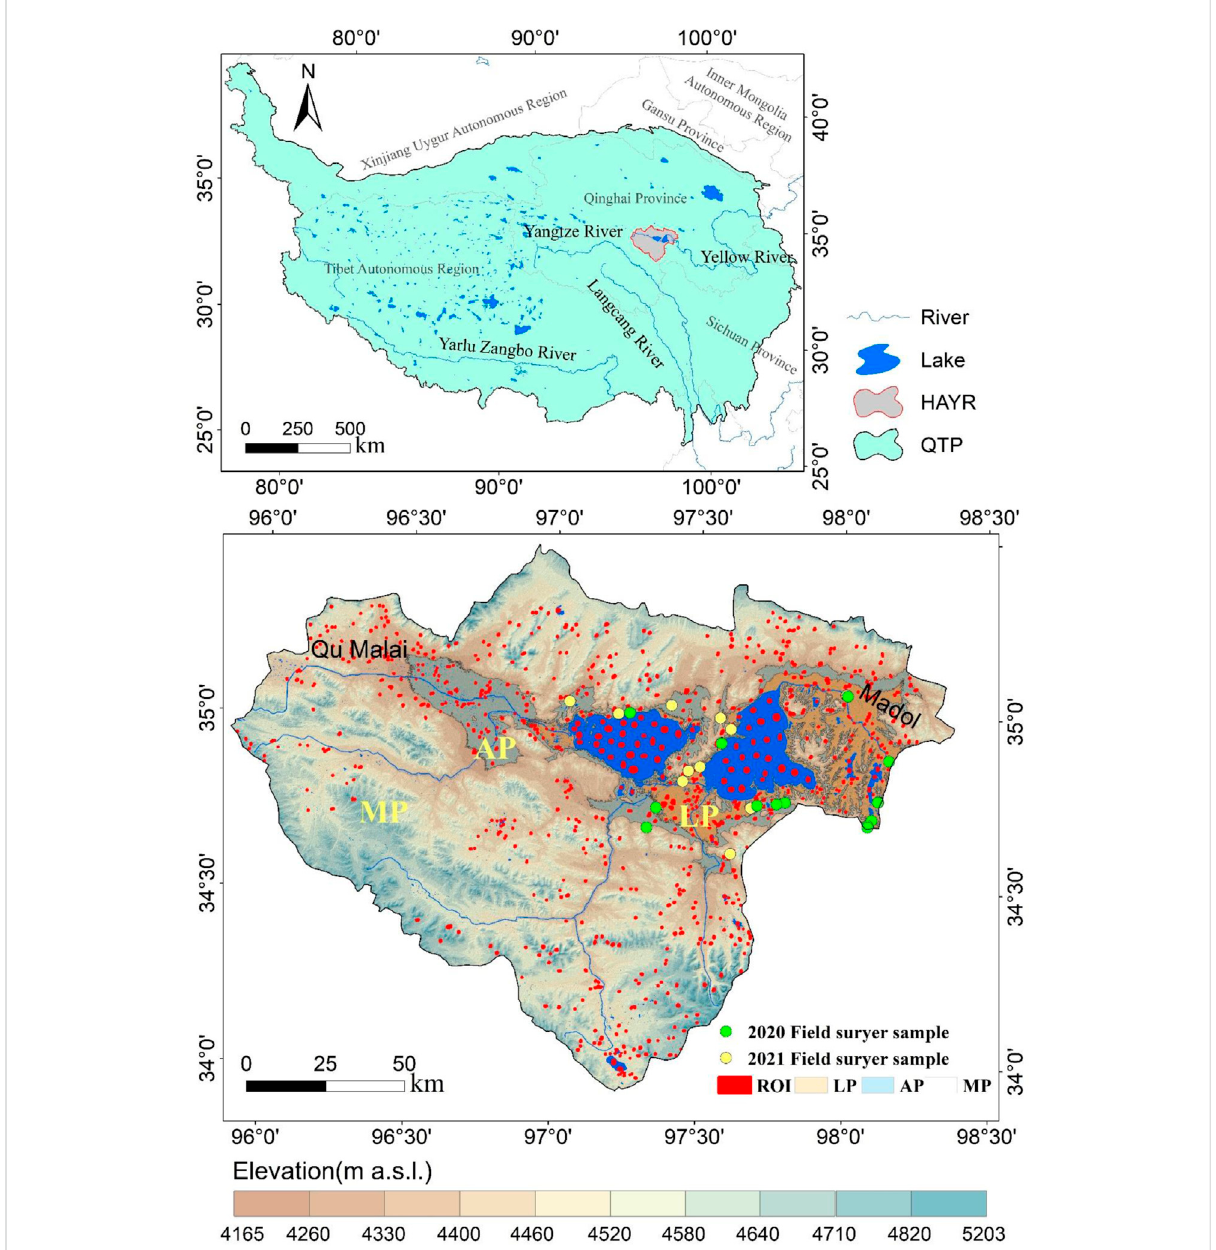
Location of the study area, Region of interests (ROI) and fi eld veri fi cation points; LP: lacustrine plain; AP: alluvial-proluvial plain; MP: mountain